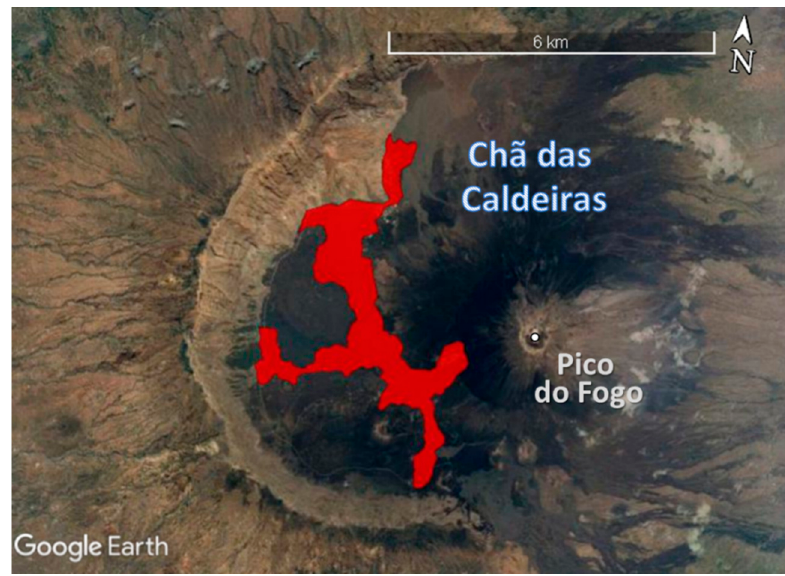
Figure 2. Reference lava flow erupted during the 2014–2015 eruption at Fogo volcano. The lava areal coverage was extracted by the Pleiades image acquired on 20 June 2015. Chã das Caldeiras is the summit caldera, inside which the active cone of Pico do Fogo rises up. This figure was generated using Google Earth.